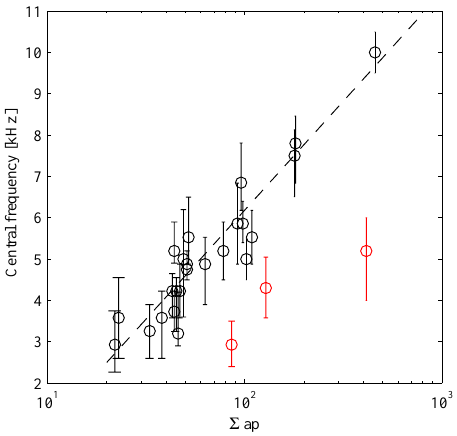
Fig. 7. Central frequency and spectral width of the BHE vs. the preceding 24h sum of A p